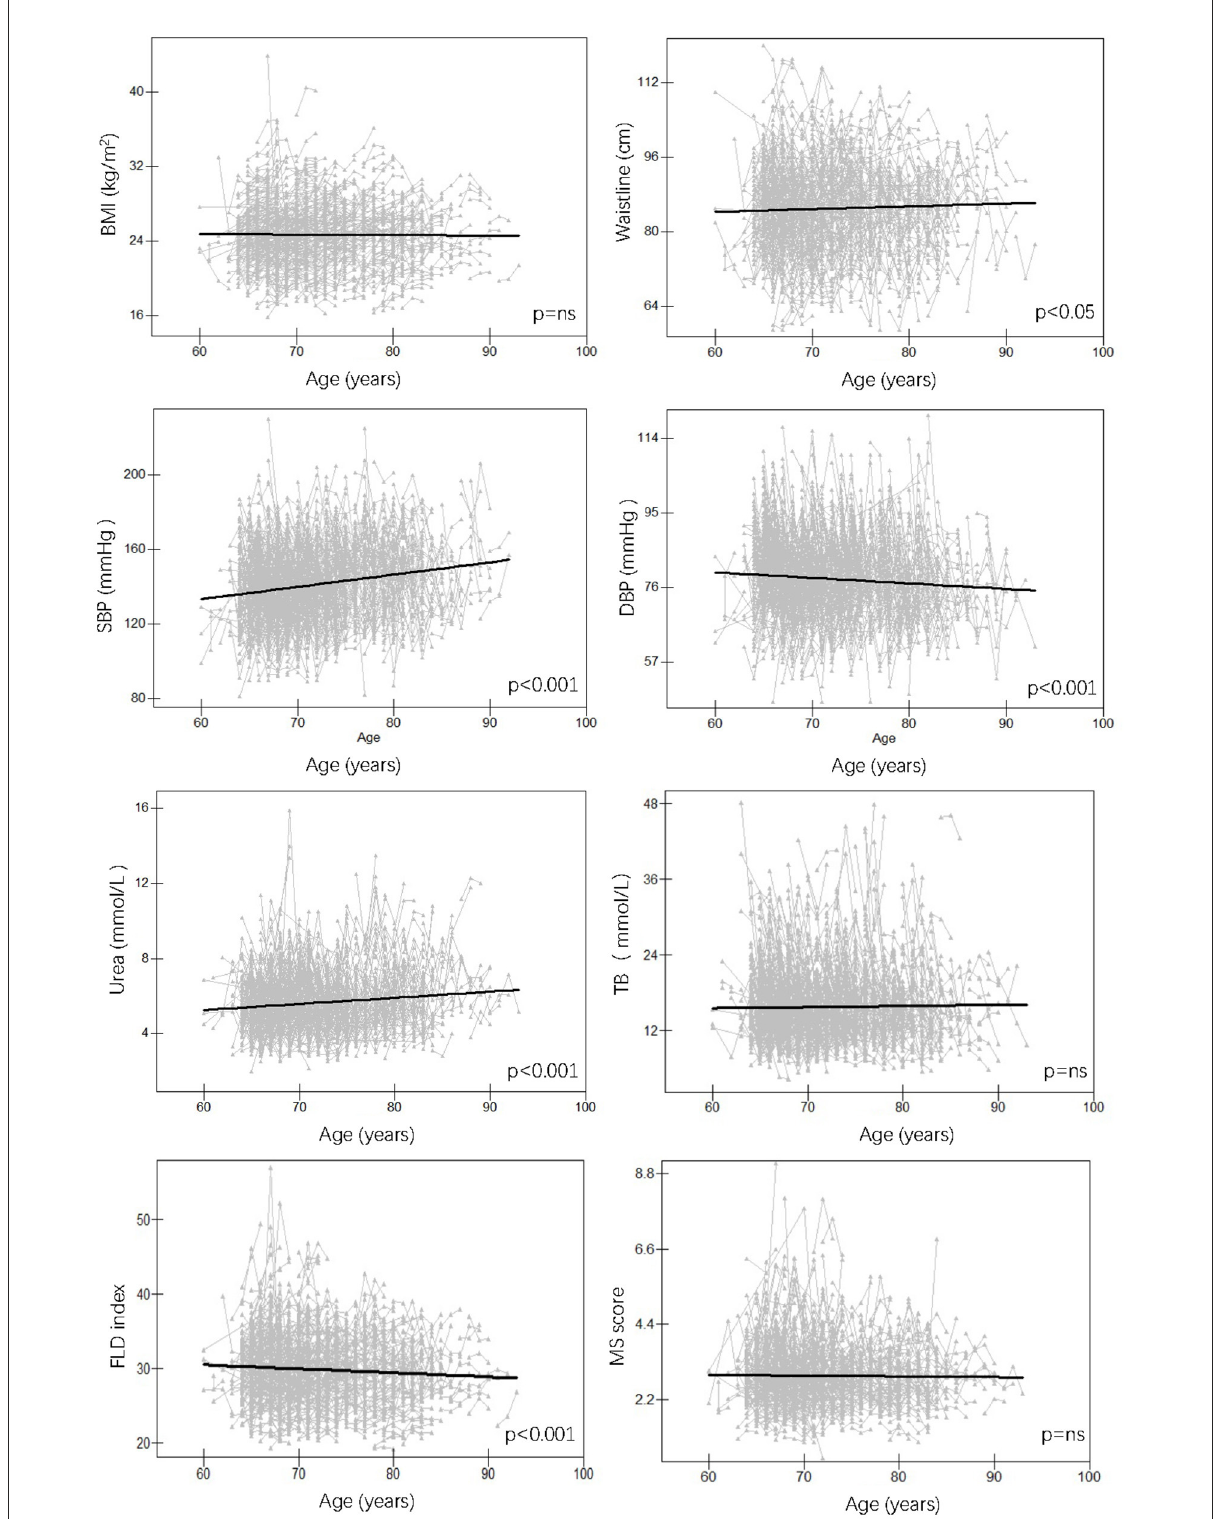
FIGURE3 Longitudinal change pattern in males. BMI, body mass index; DBP, diastolic blood pressure; FLD index, fatty liver disease index; MS score, metabolic syndrome score; SBP, systolic blood pressure; TB, total